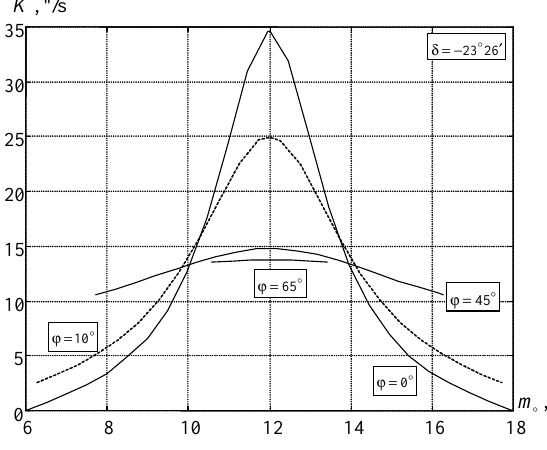
Fig 4. Coefficient K variation during summer solstice day